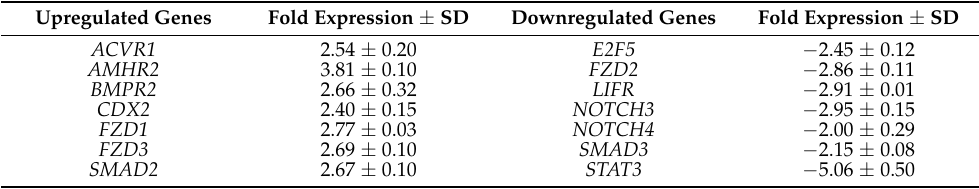
Table 5. Analysis of stem cell signaling pathway in PN-like GSC#1 during differentiation. Upregulated Genes Fold Expression ± SD Downregulated Genes